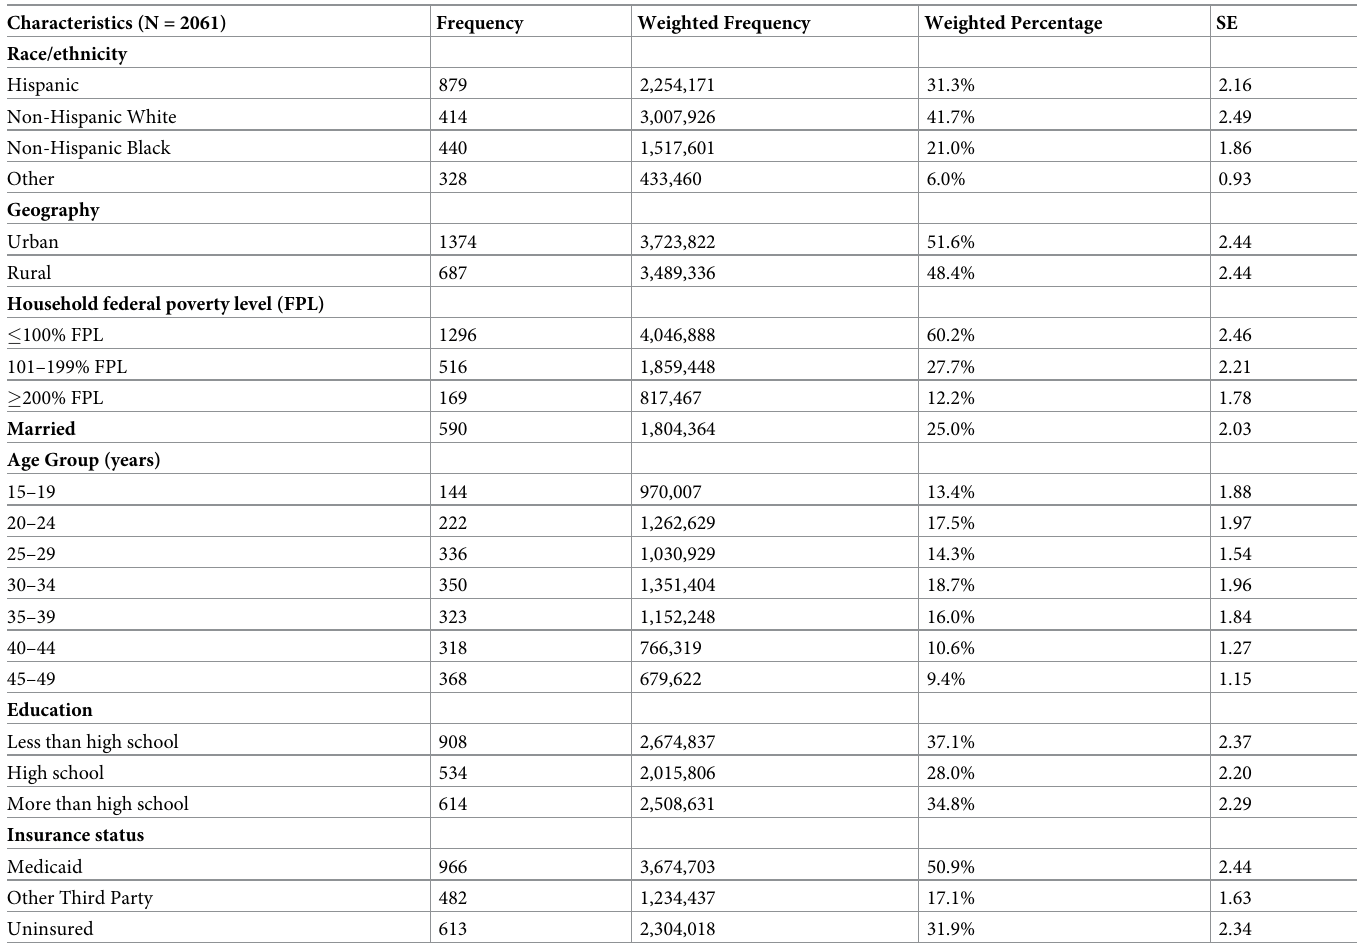
Table 1. Sociodemographic characteristics of female patients of reproductive age (15–49 yrs) served at HRSA funded health centers.